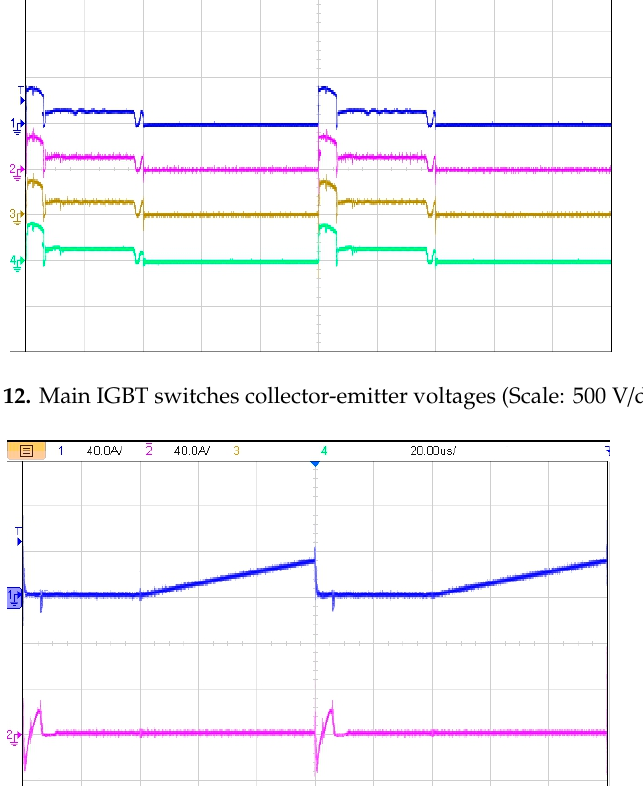
Figure 14. Main diode current (Scale: 25 A/div). To study the performance of the voltage control scheme, reference voltage changes and load impacts have been tested. Figure 15 shows the output voltage (purple) where a gradual increment in the reference voltage from 0 to 500 V is applied at the beginning. Then, when steady state is achieved, a step change in the reference voltage from 500 V to 590 V is carried out. Figure 15 (blue) shows the output current which presents the same waveform as the output voltage due to the resistive characteristic of the load. This current finally stabilizes to ~ 8 A for an output power of 4720 W.